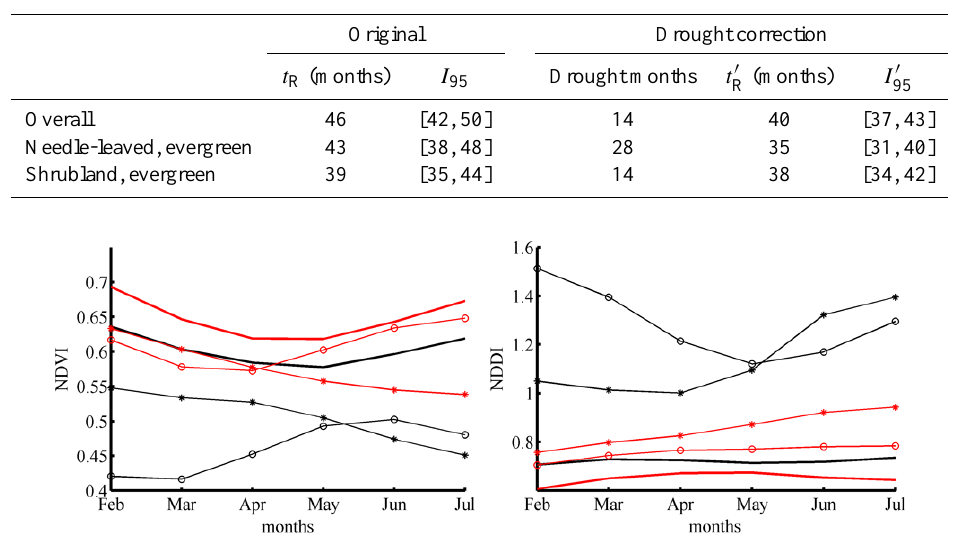
Fig. 9. Monthly values of NDVI (left panel) and NDDI (right panel) for the period of February to July 2005 averaged over all the considered 2005 burnt scars (solid line), over A5 (circles) and over A6 (star), for burned (red) and unburned (black)